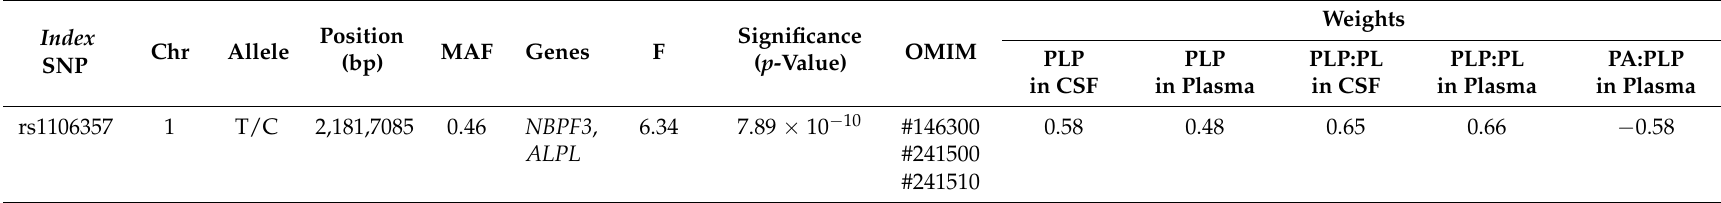
Table 2. Genome-wide significant locus for B6 vitamer (PL, PLP) and PA concentrations and ratios in and between CSF and plasma ( n = 493). Only weights ≤− 0.30 or ≥ 0.30 are